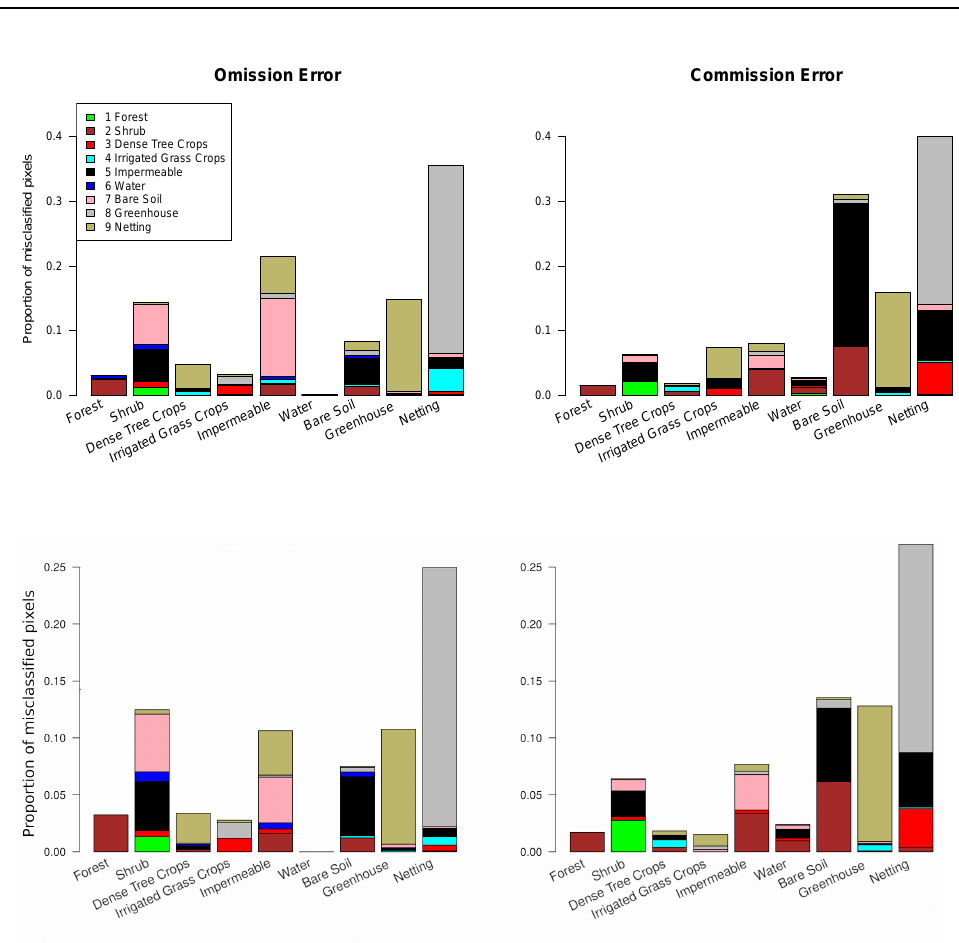
Figure 5. Confusion between classes in the S2 model ( above ) and the final model ( below ). Most of the confusions represent a really small proportion of pixels and can be con- sidered residual noise. The most frequent confusions are between scrubs, bare soil and impermeable areas on the one hand, and greenhouses and netting on the other hand. We think these errors represent a more general lack of separability among classes. In semiarid areas, the distinction between scrubs and bare soil is very fuzzy. Moreover, in the surround- ings of urban areas, there are frequently pixels mixing isolated houses, bare soil and some disperse scrubs. The confusion among greenhouses and netting is the quantitatively most salient (see also Table 8). It may be explained because the spectral signatures of both classes may be similar. However, it is not a very relevant confusion as both are, from an agronomic point of view, subclasses of irrigated